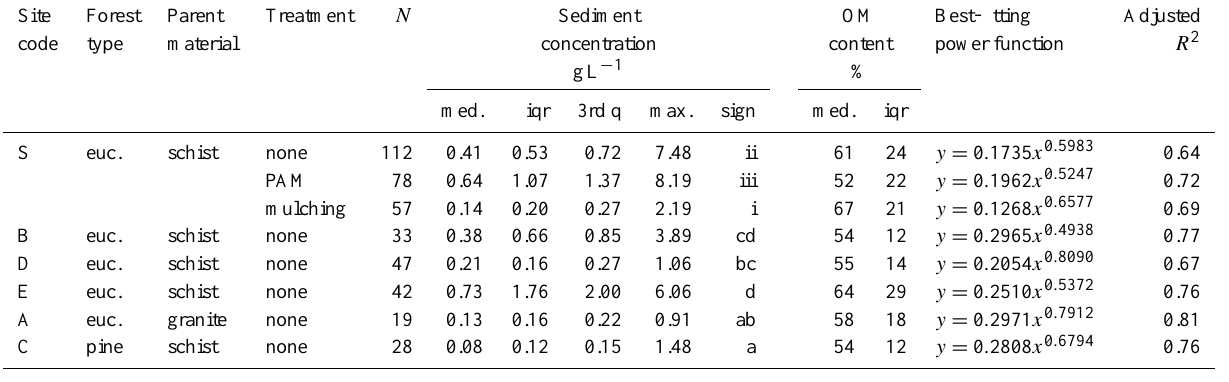
Table 2. Sediment concentrations and corresponding organic matter (OM) contents of the micro-plot scale overland flow samples at the six study sites, and best-fitting power functions between sediment concentration ( x ; in gL − 1 ) with normalized light loss ( y ). Euc.: eucalypt; med.: median; iqr: inter-quartile range; 3rd q: third quartile; max.: maximum; sign: statistically significant differences, at α = 0.05, are indicated by different roman numbers in the case of the treatments tested at the S site and by different letters in the case of the other sites.